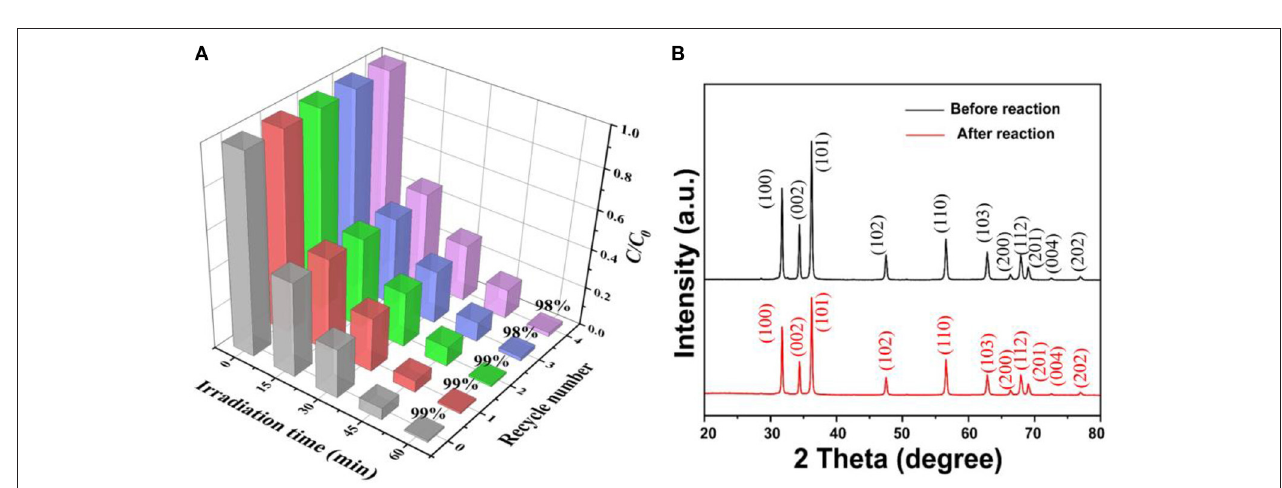
FIGURE 8 | (A) Photocatalytic degradation of BPA over the ZnO photocatalyst over five cycles; (B) XRD patterns of the ZnO photocatalyst after five cycles.